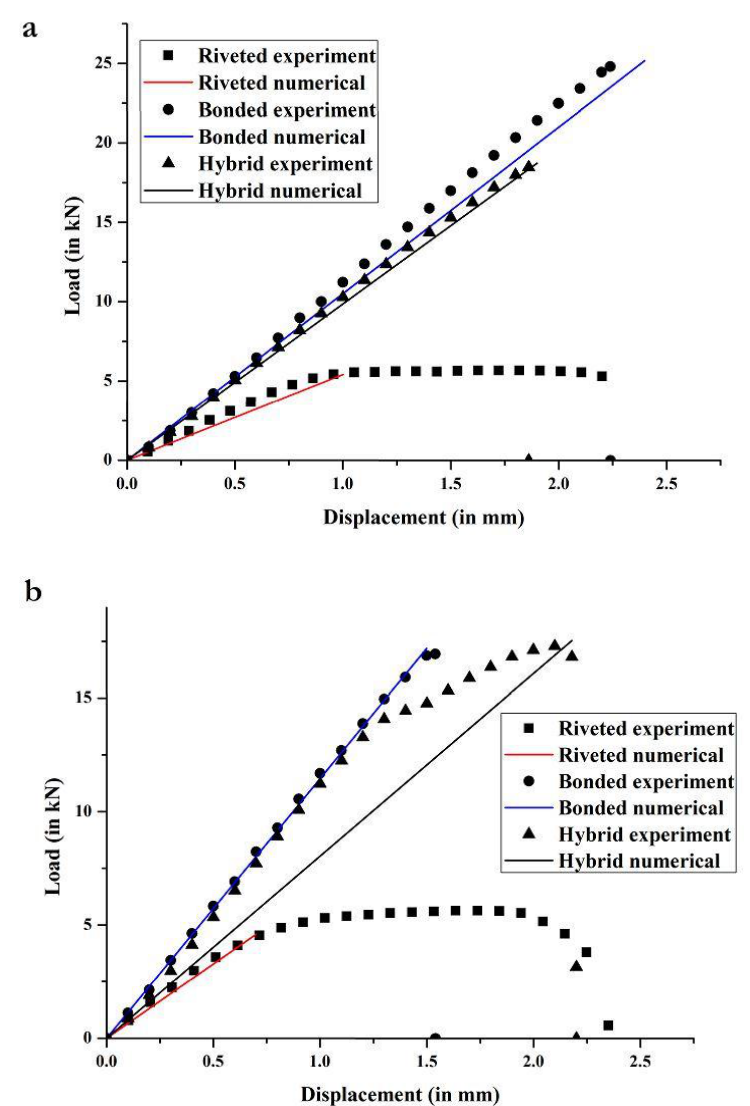
Figure 7. Experimental and numerical load versus displacement curves for riveted, adhesive bonded, and hybrid joints for ( a ) composite-composite and ( b ) composite-metal configurations.